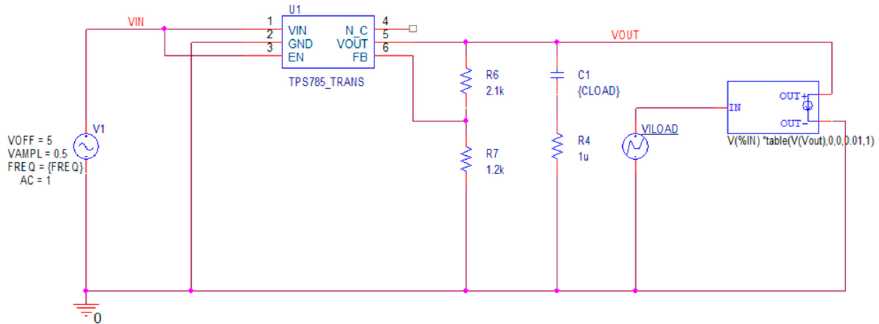
Figure 14. Transient test-bench circuit for TPS785-Q1 PSRR simulation.